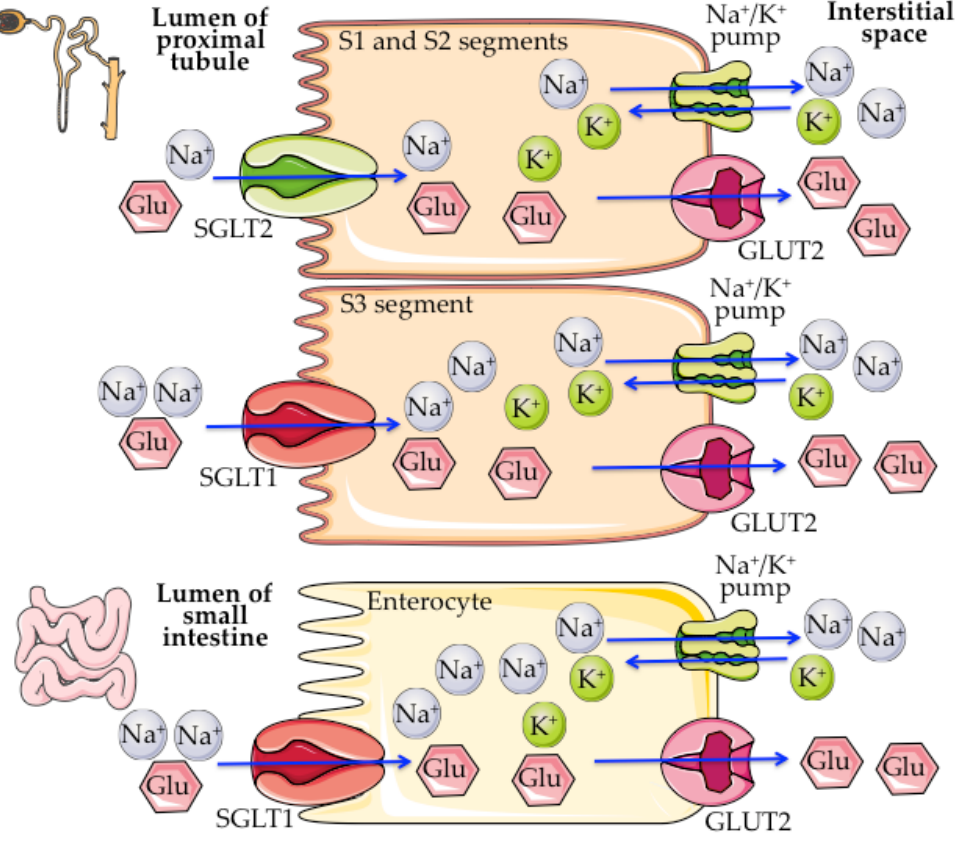
Figure 1. Main sites of expression and function of SGLT1 and SGLT2. Glu: glucose. GLUT2: Facili- tated Glucose Transporter Member 2. The figure was drawn using pictures from Servier Medical